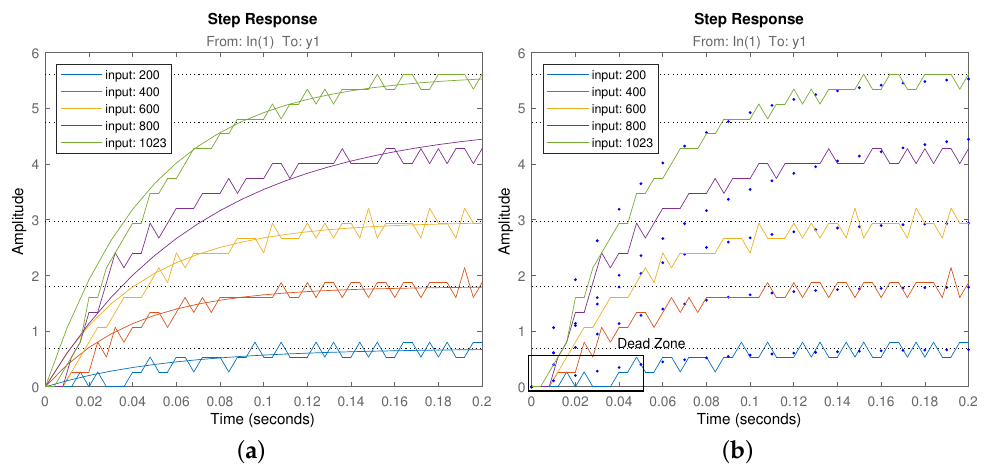
Figure 11. Motor system identification. Different systems identified depending on the inputs ( a ) and average system time response ( b ) compared to the captured data.